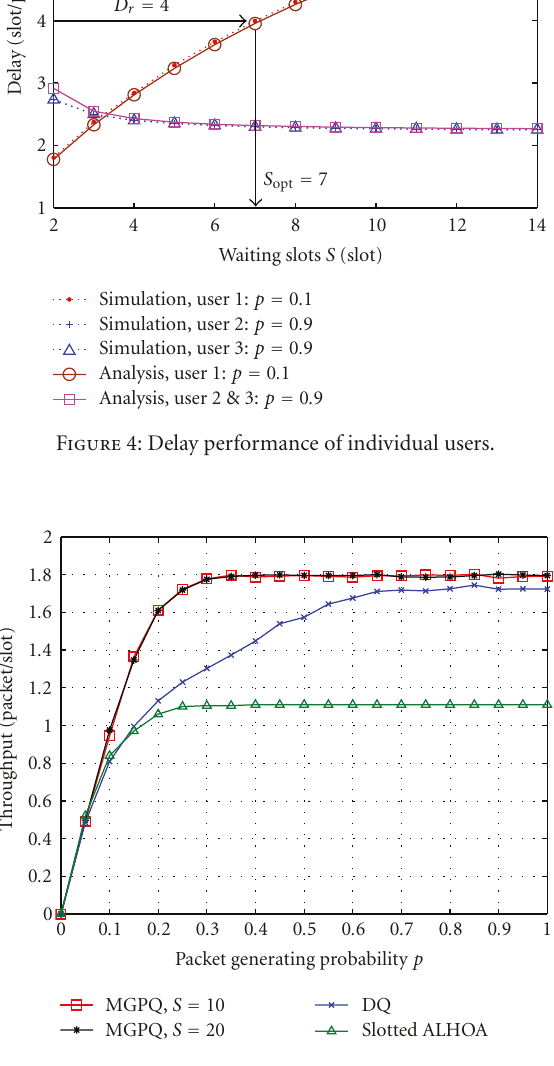
Figure 3: Mean delay performance of the proposed MGPQ.